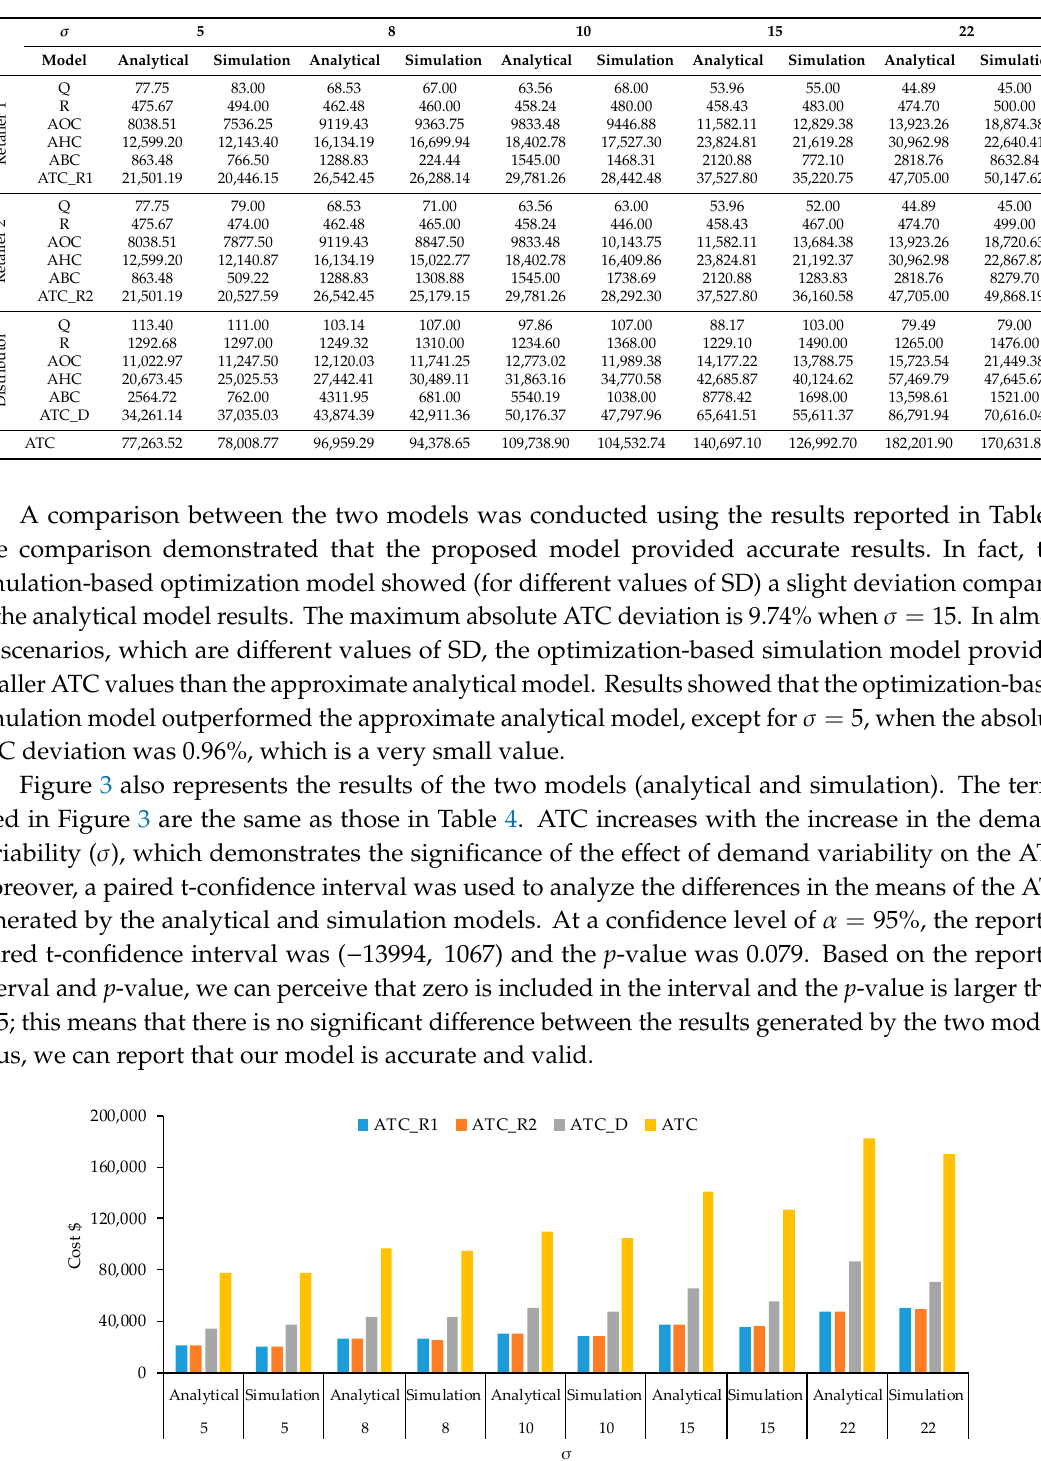
Table 4. Results of the simulation-optimization model and the analytical method.